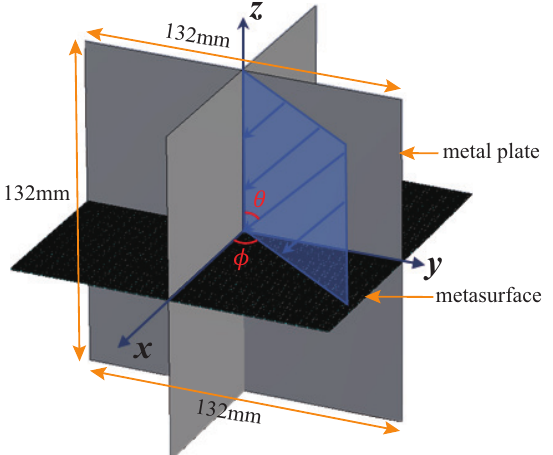
Figure 4. The structure of the electronically controlled eight-quadrant corner